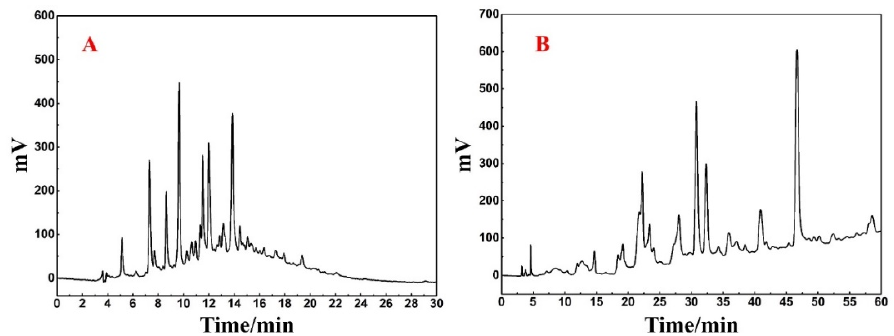
Figure 3. ( A ) Analysis chromatogram of Fr3 ‐ 1 on Reprosil ‐ Pur C18 AQ analytical column. ( B ) Anal ‐ ysis chromatogram of Fr3 ‐ 1 on Click XIon analytical column.